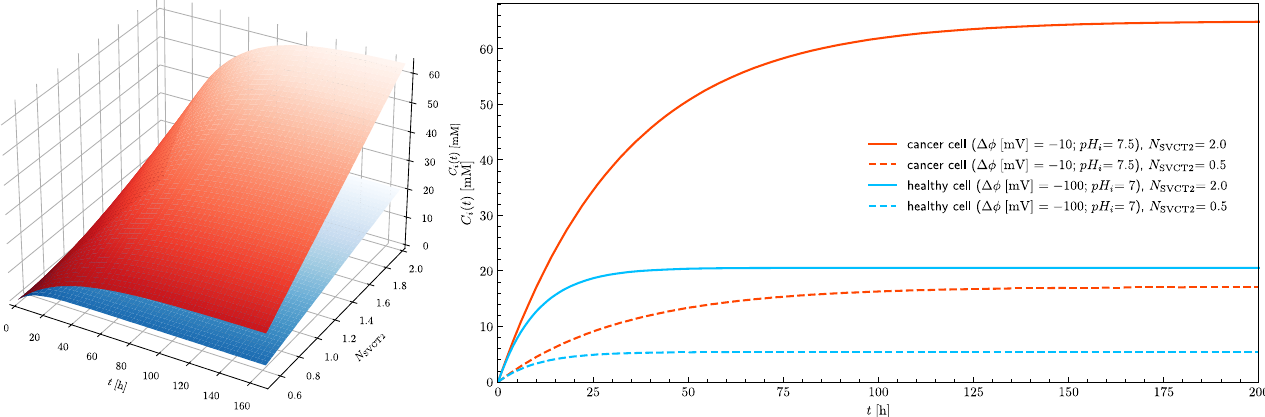
Figure 7. The effect of the number of SVCT2 transporters on the rise of the intracellular ascorbate concentration in time towards the steady-state value for healthy (blue) and cancer (red) cells (left panel). The right panel shows traces of intracellular ascorbate concentration as a function of time for healthy (blue traces) and cancer (red traces) cells. Traces show cases when the number of SVCT2 transporters equal 0.5 and 2 for pH e = 7.4.